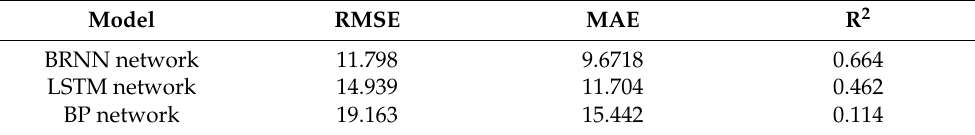
Table 9. Evaluation results of different models.